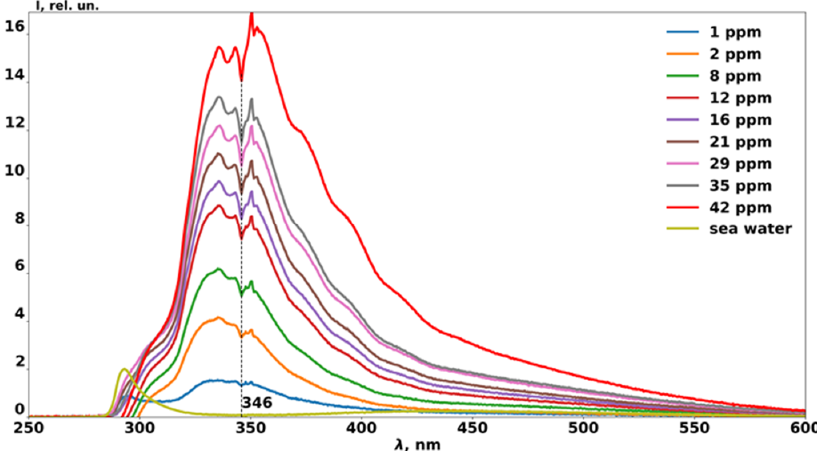
Photonics 2020 , 7 , x FOR PEER REVIEW Figure 6. LIF spectra of the DMA solutions. Figure 6. LIF spectra of the DMA solutions.